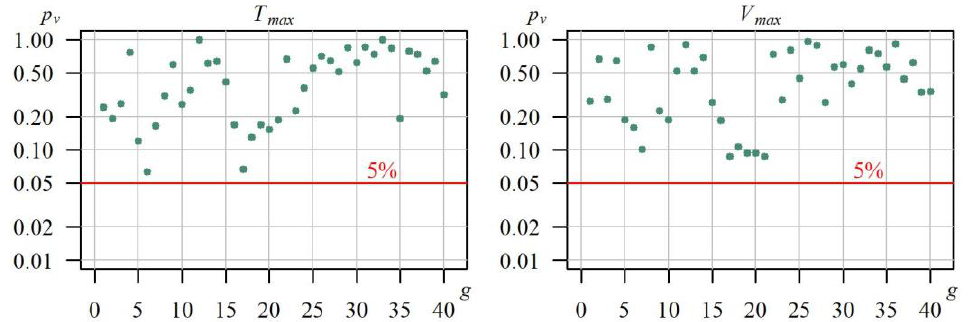
Figure 7. The p v -value obtained from the Mann–Kendall test for the time series of duration T g max and volume V g max of the maximum drought in the hydrological period between 1991 and 2020.